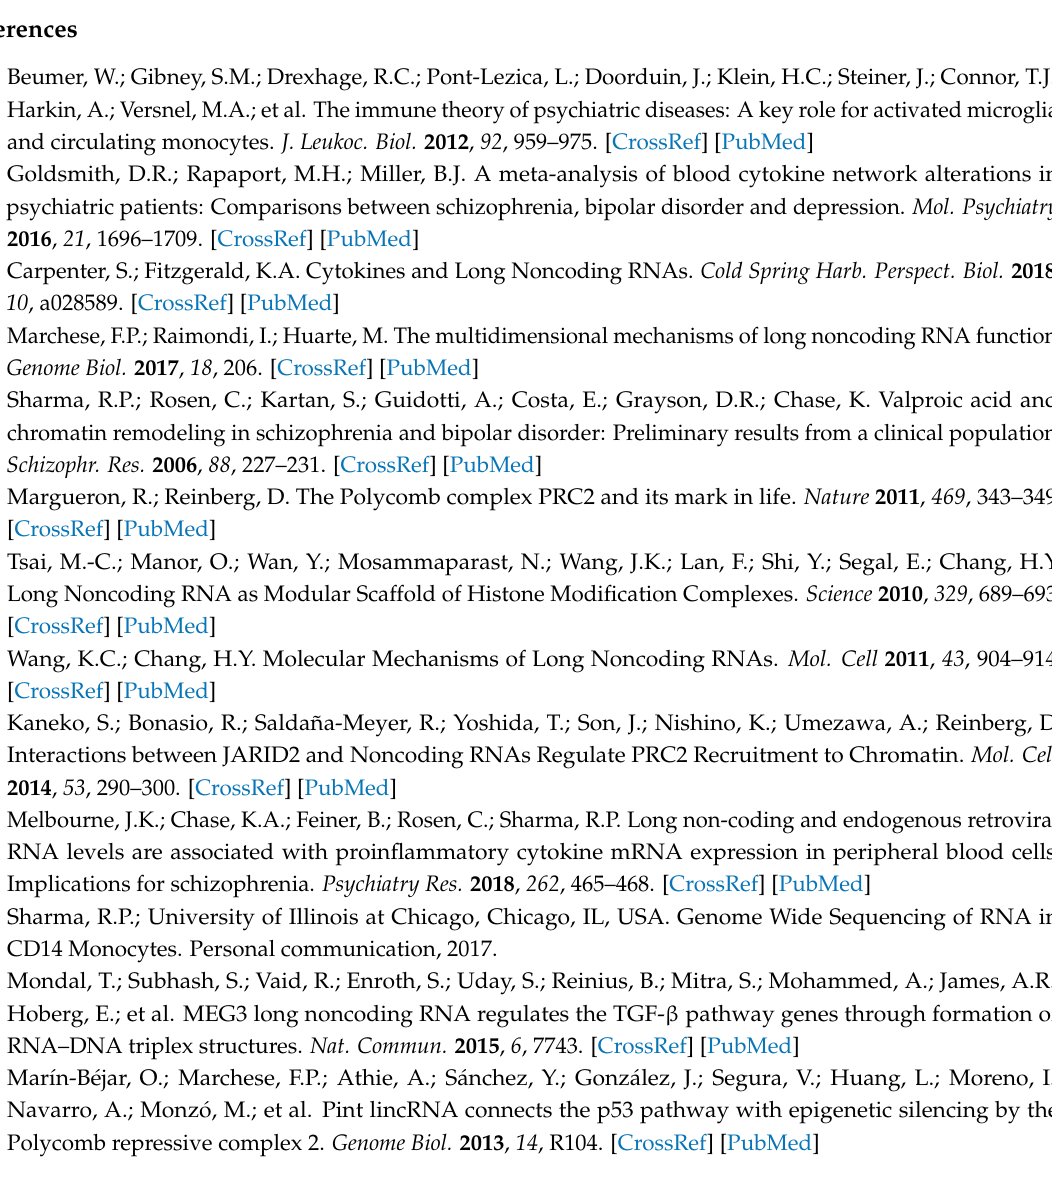
Figure S1: Correlation between symptom severity and lncRNA expression. Figure S2: Correlational strength between lncRNA expression and disease severity (PANSS five factor sub-scale). Figure S3: Dendrograms and heat map of hierarchical clustering analysis (complete-linkage) by the expression of lncRNAs MEG-3, PINT and GAS-5. Figure S4: Receiver Operating Characteristic Curve (ROC) for predicting clinical diagnosis with lncRNAs (MEG-3, PINT and GAS-5)